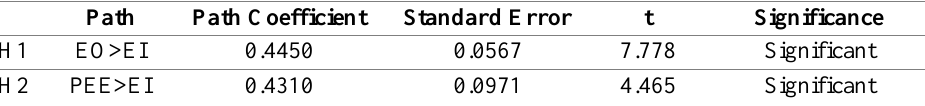
Table 08: Summary of structural model